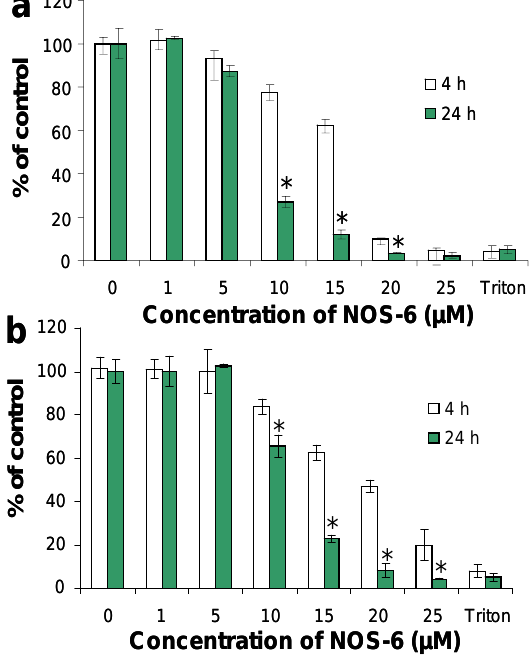
Figure 3. The effect of NOS-6 on the viability of mouse fibroblasts (BALB/c cells). Fibroblasts were treated with NOS-6 (1–25 μ M) for 4/24 h; control cells were incubated with DMSO (0.5%; v/v) under the same conditions. Cell damage was evaluated as (a) NR retention and (b) MTT assay. Data are expressed as percentage of control and plotted as means ± S.D. *) p < 0.05 statistically different from 4 h